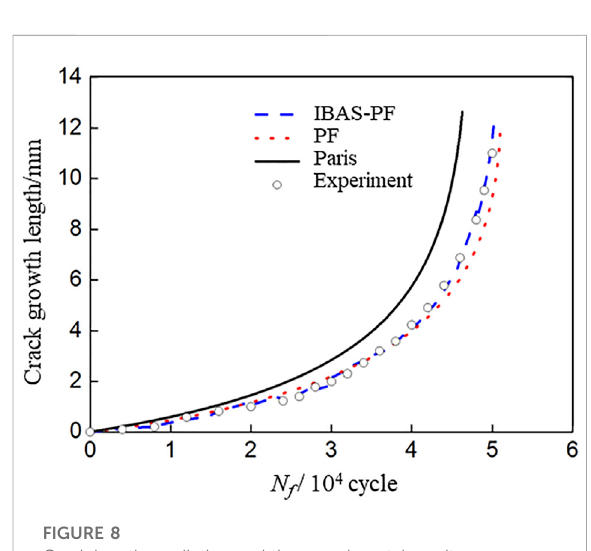
FIGURE 8 Crack length prediction and the experimental results.